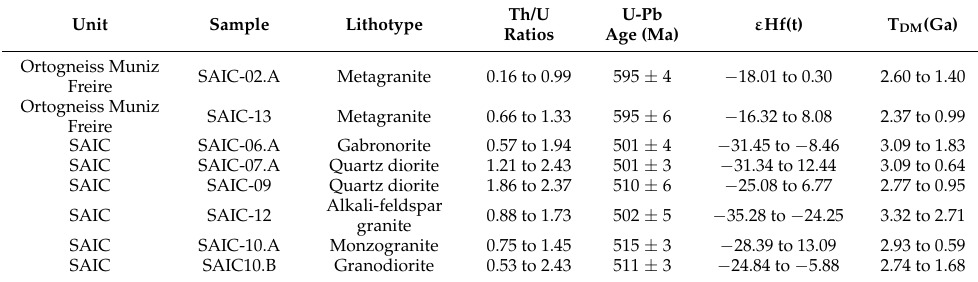
Table 1. Summary of the results obtained in this